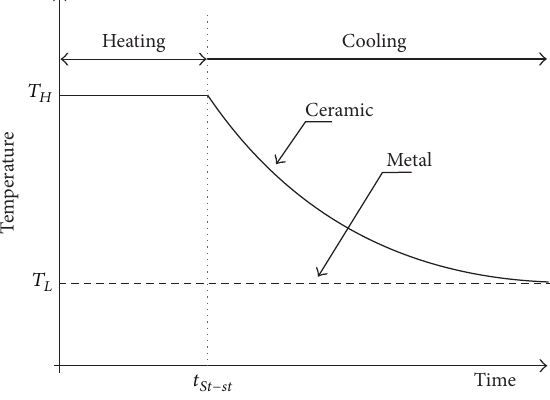
Figure 8: A scheme of thermal